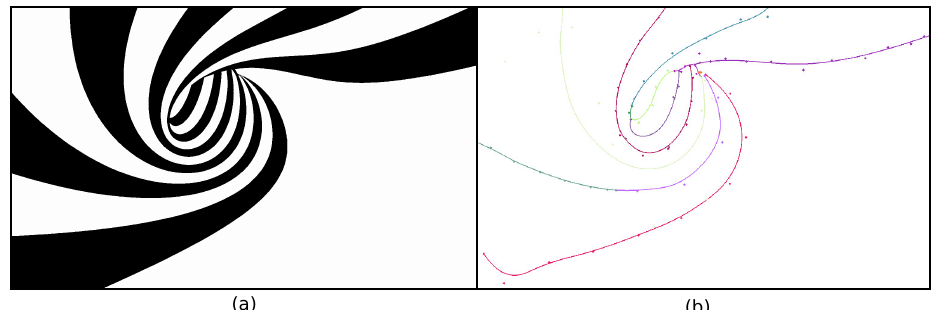
Figure 17. One of the level-sets for the geometric image in Figure 16 ( a ) and its corresponding B-spline MAT representation ( b